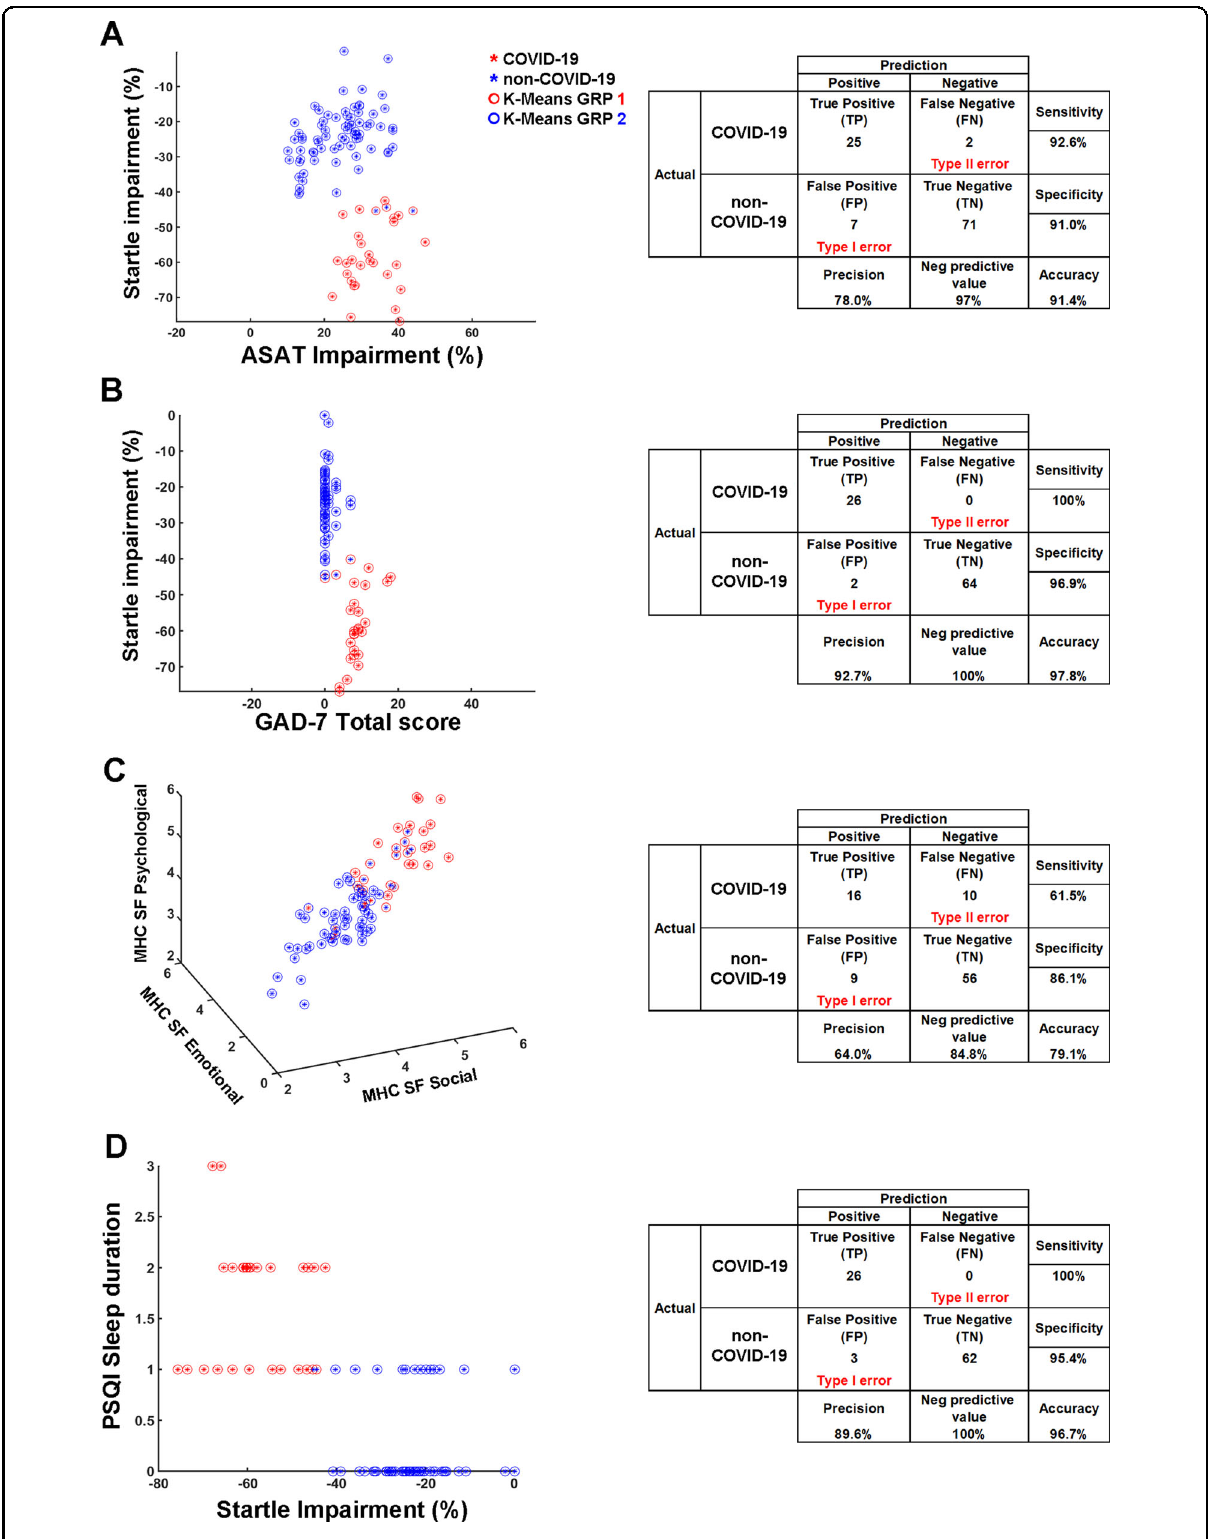
Fig. 4 Comparing clustering of COVID-19 and non-COVID-19 groups. Clustering of the differences between COVID-19 and non-COVID-19 physicians. A The physiological measures of startle (anxiety) and ASAT (attention) impairments, B Anxiety measured both by startle response (while residents) and GAD-7 report (during the COVID-19 pandemic). C Mental health psychological, social, and emotional aspects; and D sleep duration report and startle impairment. Sensitivity, speci fi city, and accuracy of the prediction are depicted for each analysis. The asterisk represents the real-life group and the circle represents the algorithm